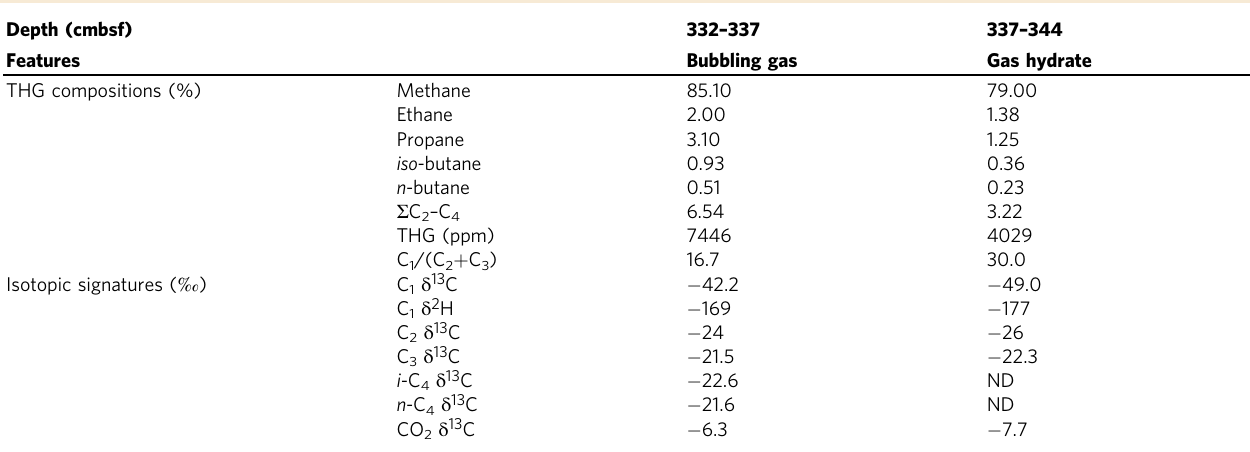
Table 1 Molecular and isotopic compositions of two gas samples sourced from sediments subsampled from the core regions nearest gas